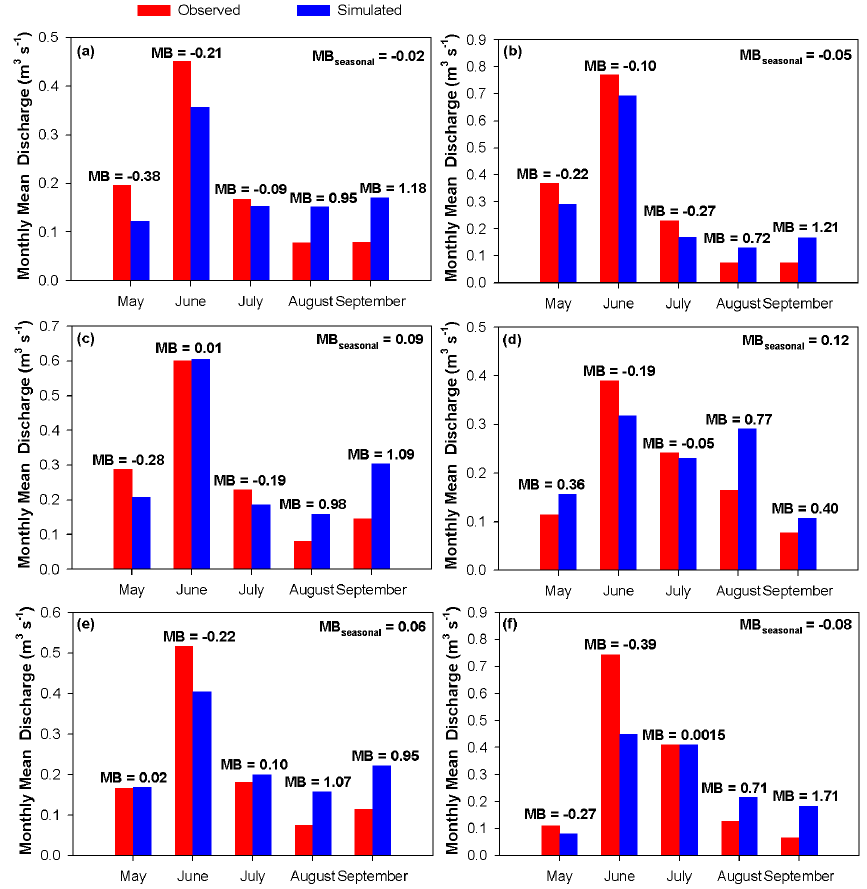
Fig. 11. Comparisons of observed and simulated monthly streamflow at the outlet of Marmot Creek during (a) 2006, (b) 2007, (c) 2008, (d) 2009, (e) 2010, and (f)